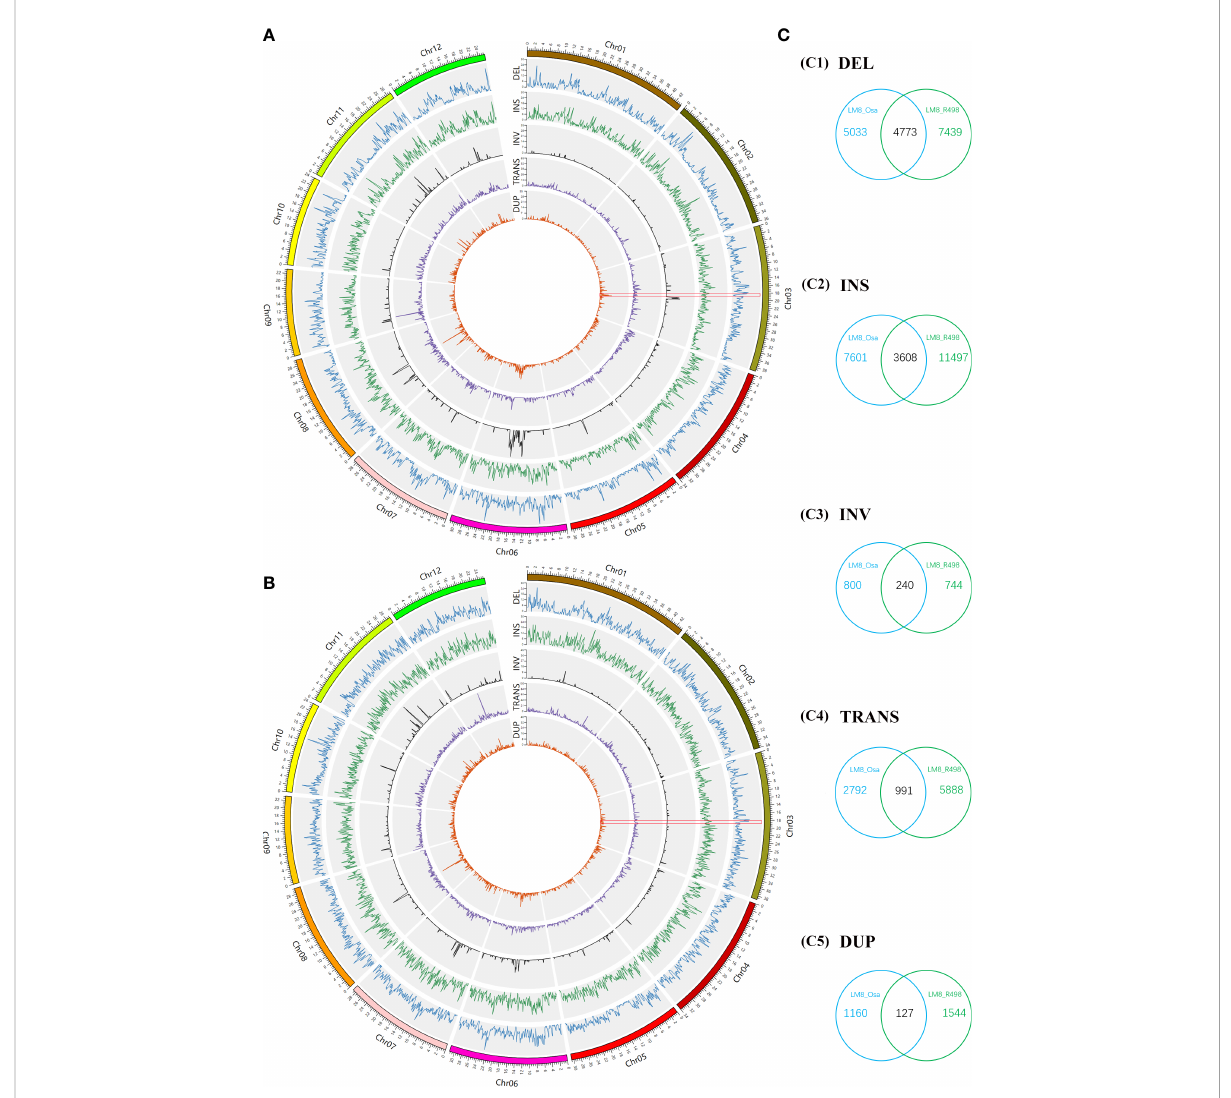
FIGURE 2 Whole-genome comparisons between LM8 and NIP and between LM8 and R498. (A) Circular diagram of the variation distribution and density on 12 chromosomes in LM8 revealed by the LM8 vs NIP comparison. (B) Circular diagram of the variation distribution and density on 12 chromosomes in LM8 revealed by the LM8 vs R498 comparison. (C) Venn diagram analysis of the number of variations. DEL, deletion; INS, insertion; INV inversion; TRANS, translocation; DUP,